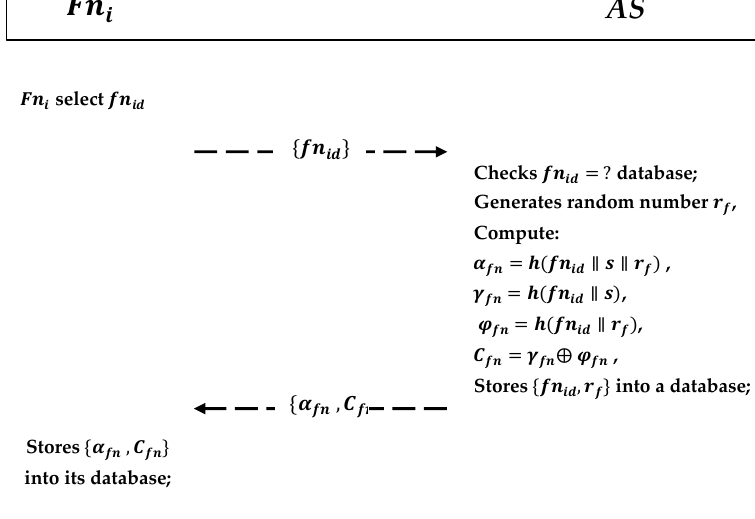
Figure 6. Fog node registration